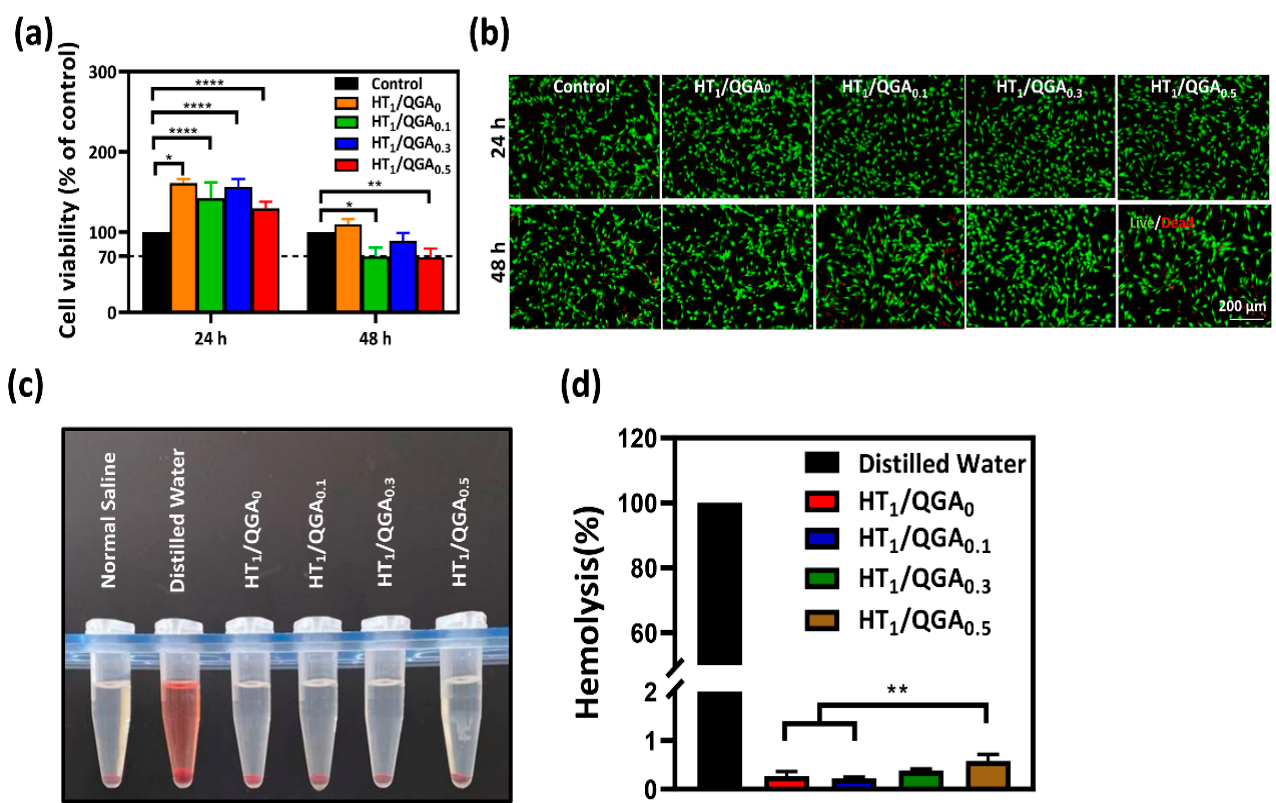
Figure 6. ( a ) BMSCs viability of HT/QGA hydrogel extracts by CCK-8; ( b ) live (Calcein-AM)/dead (PI) dyeing of BMSCs; ( c ) photograph of hemolysis test and ( d ) hemolysis ratio of HT/QGA hydrogels. * p < 0.05, ** p < 0.01, **** p < 0.0001, mean ± SD, n = 3.